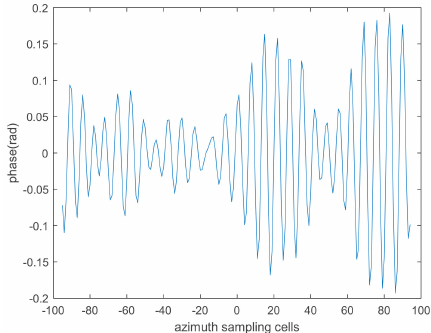
Figure 33. Estimated vibration phase.